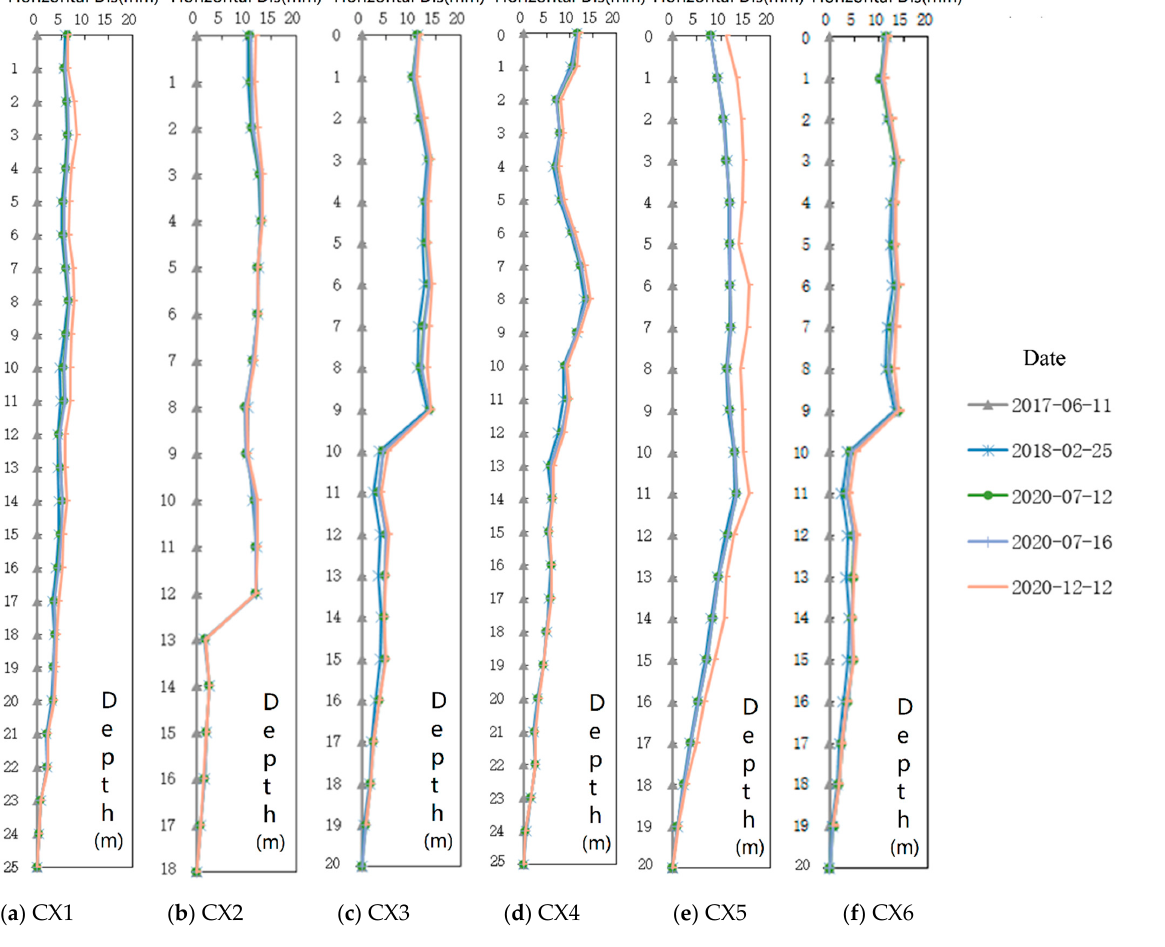
Figure 15. Cumulative monitoring data of six deep horizontal displacement monitoring points of Fangshan landslide from 11 June 2017 to 12 December 2020. Their positions are shown in Figure 6.